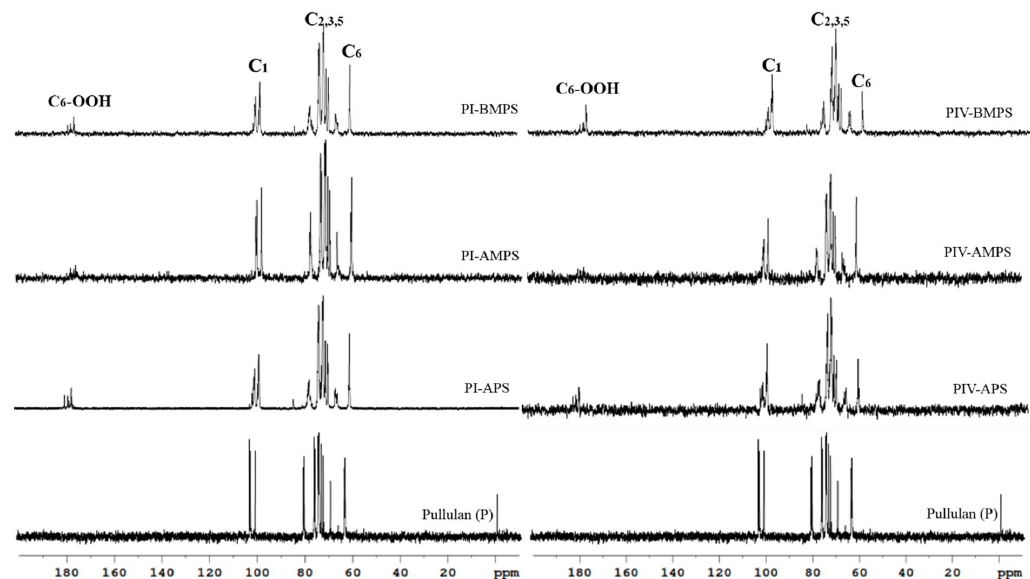
Figure 4. Selected 13 C-NMR spectra of the pullulan obtained after oxidation in the presence of NHPI-supported catalysts catalysts/NaClO/NaBr.